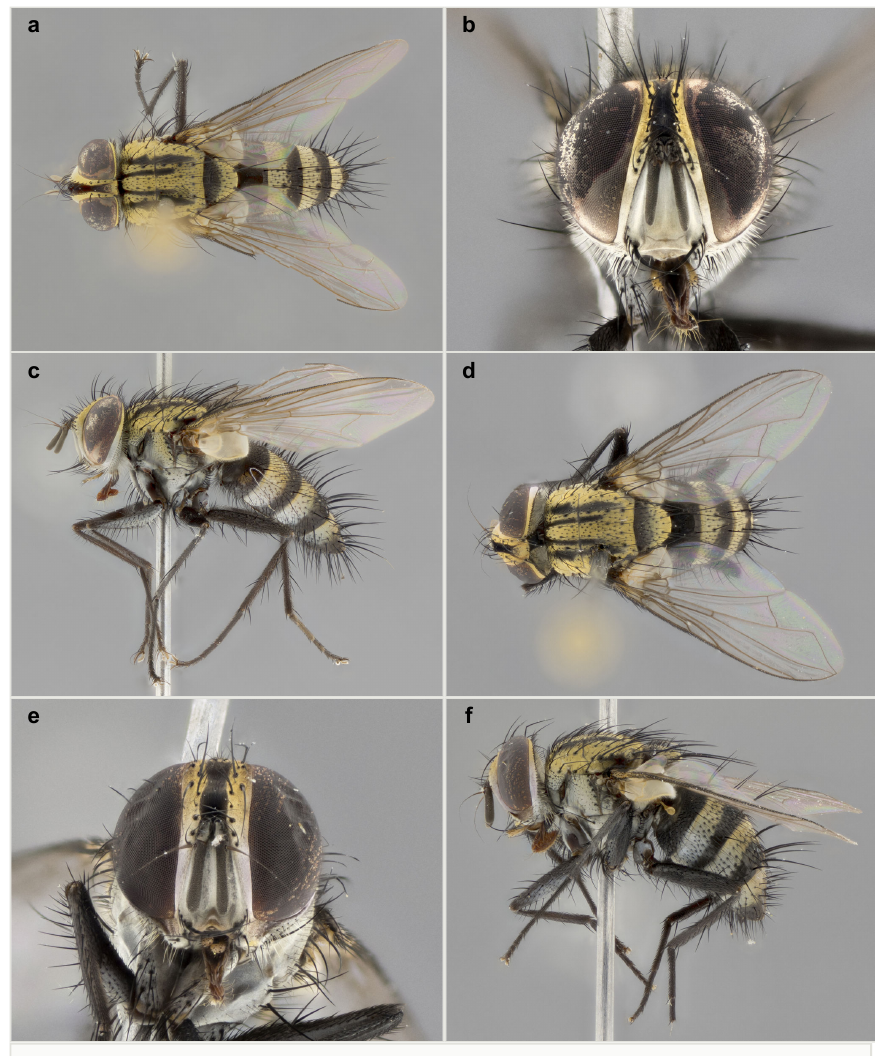
General morphology of Calolydella virginiajamesae sp. n. ; a–c : male holotype, voucher